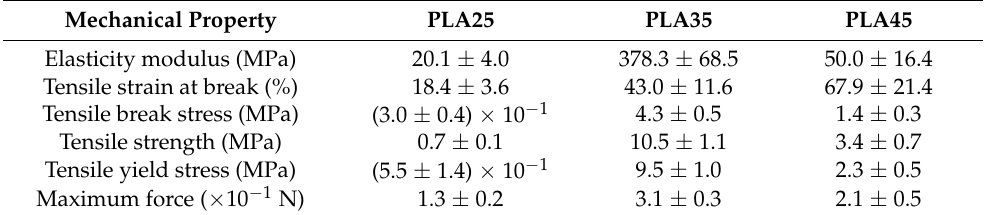
Figure 7. Strain–stress curves for the three electrospun/electrosprayed PEG/PLA films. Table 2. Summary of the mechanical properties of the three electrospun/electrosprayed PEG/PLA films.